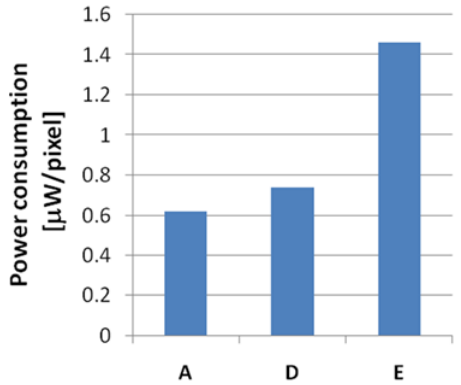
Figure 11. Power consumption for the three cases: ( A ) the proposed pixel-level ADC; ( D ) pulse frequency modulation (PFM)-based two-stage analog-to-digital (A/D) conversion; ( E ) 1st-order incremental ADC.